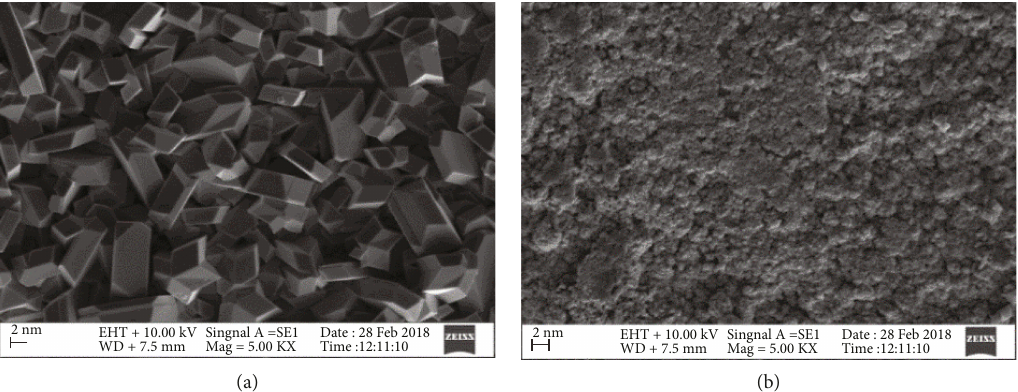
Figure 3: SEM micrographs of CuI deposited on the TiO